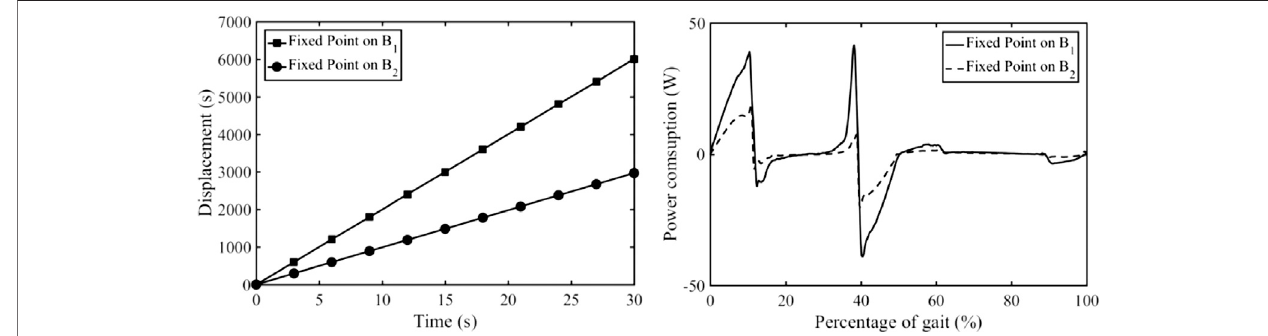
FIGURE 13 | Horizontal displacement and power consumption of the actuator with fi xed points: B1 and B2.